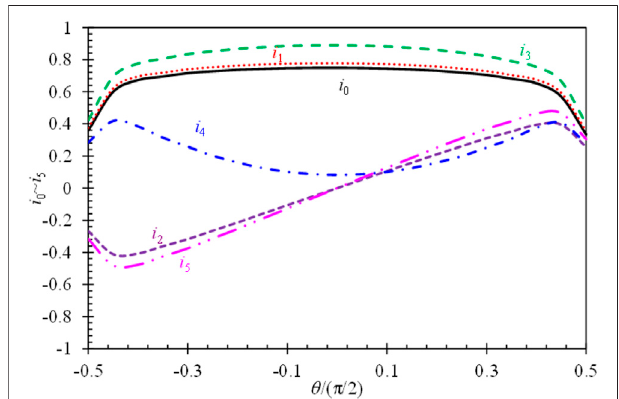
FIGURE 10 | In fl uence coef fi cients along the crack front ( c (cid:1) 0.185, κ (cid:1) 0.141, δ (cid:1) 1, φ (cid:1) 0.5, and R (cid:1) 0 mm).